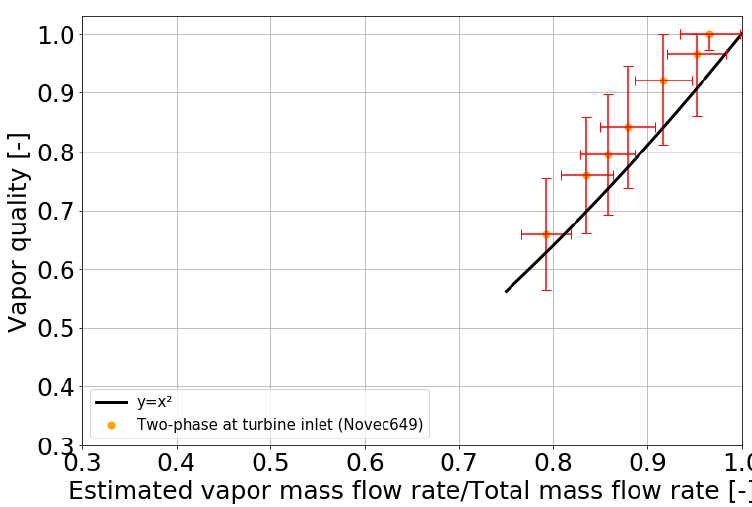
Figure 13. Quality based on the vapor mass flow rate/total mass flow rate.